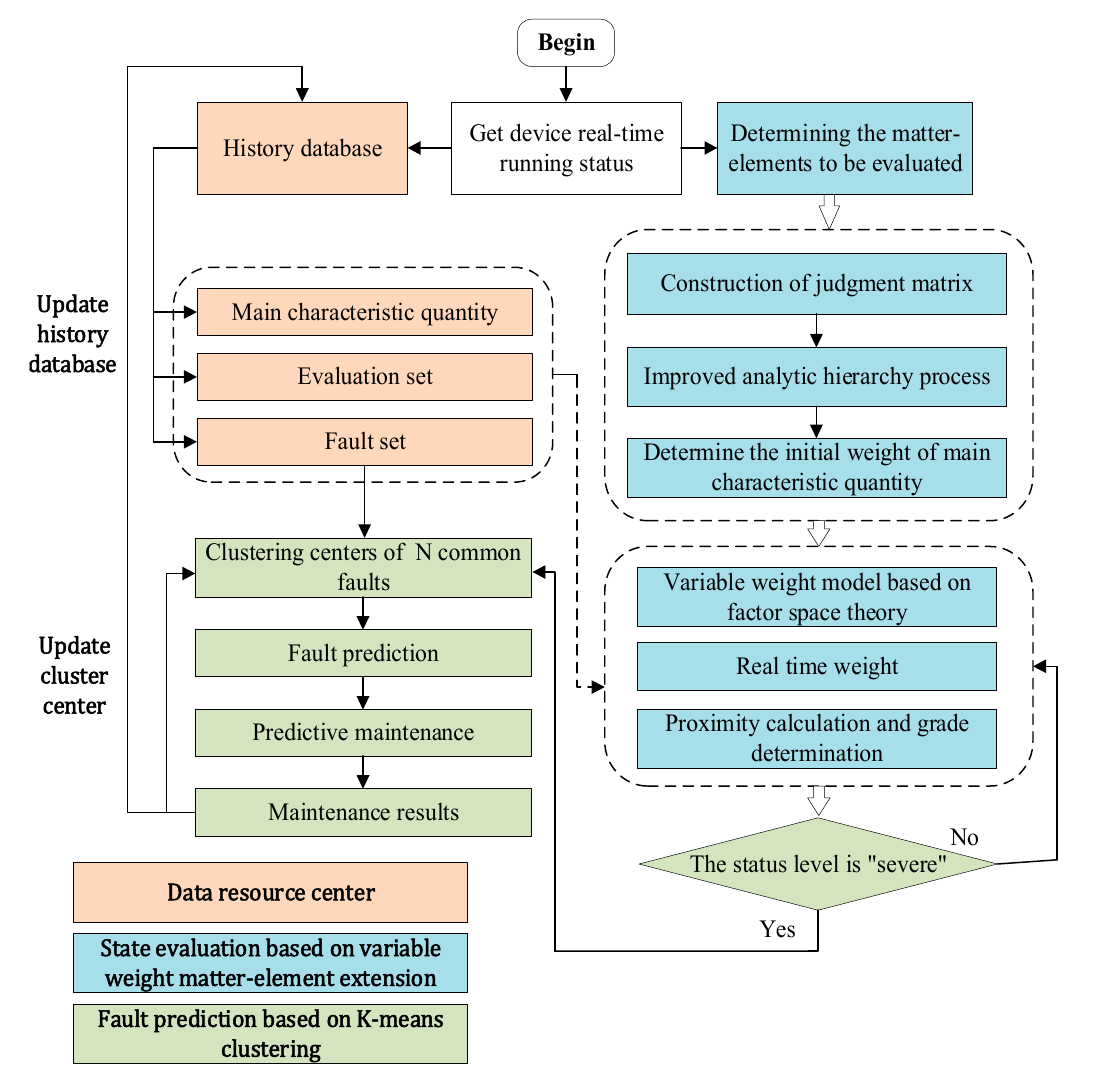
Figure 3. Workflow of Digital Twin Model Layer.